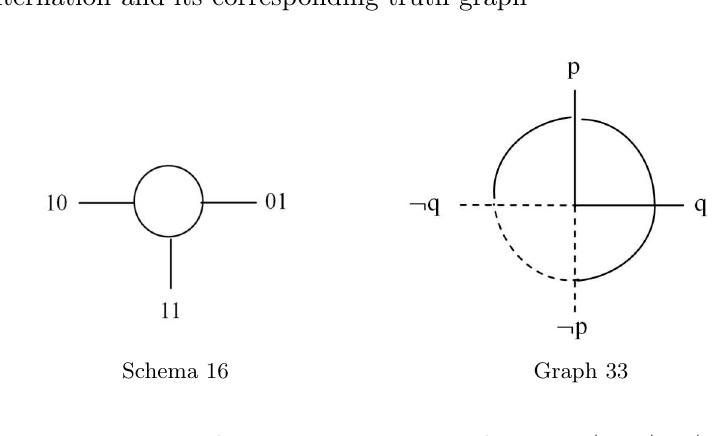
Schema 16 stands for a two-place basic formula: ⌊ p q ⌋ (pq), while graph 33 (also see graph 10(a), 11(d)) stands for assertions: ⊢ p ∨ q, ⊢ ¬ p → q. Both schema 16 and graph 33 mean that the whole expression is true iff ‘p’ is true (has value 0) and ‘q’ is false (has value 0), or, ‘p’ is false and ‘q’ is true, or, both ‘p’ and ‘q’ are true.